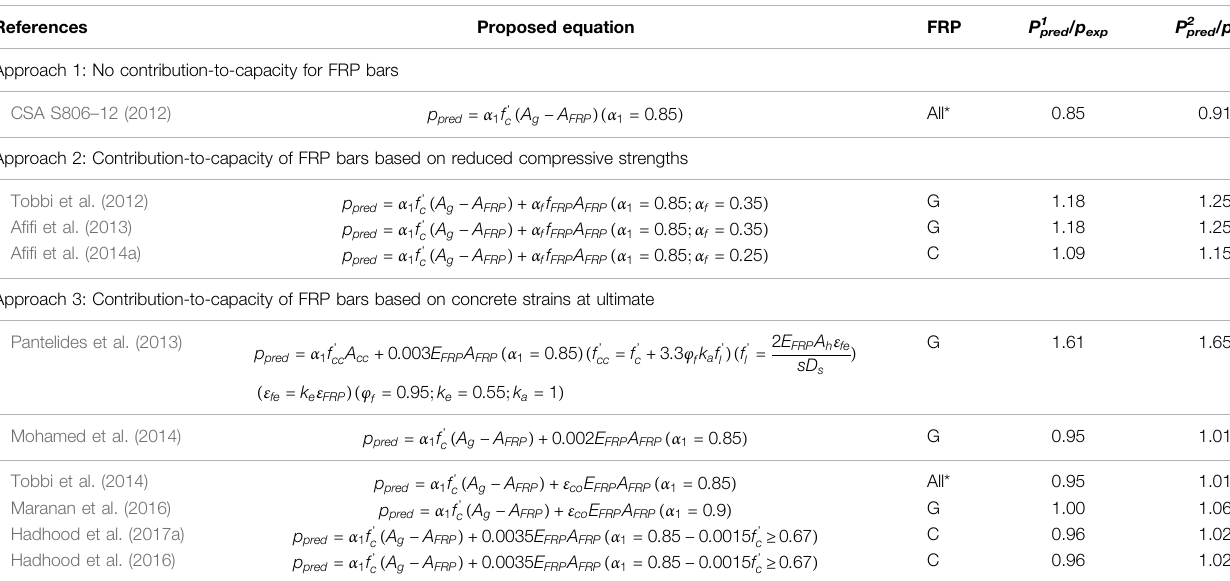
TABLE 1 | Summary of mathematical expressions reported by the researchers for GFRP-RC